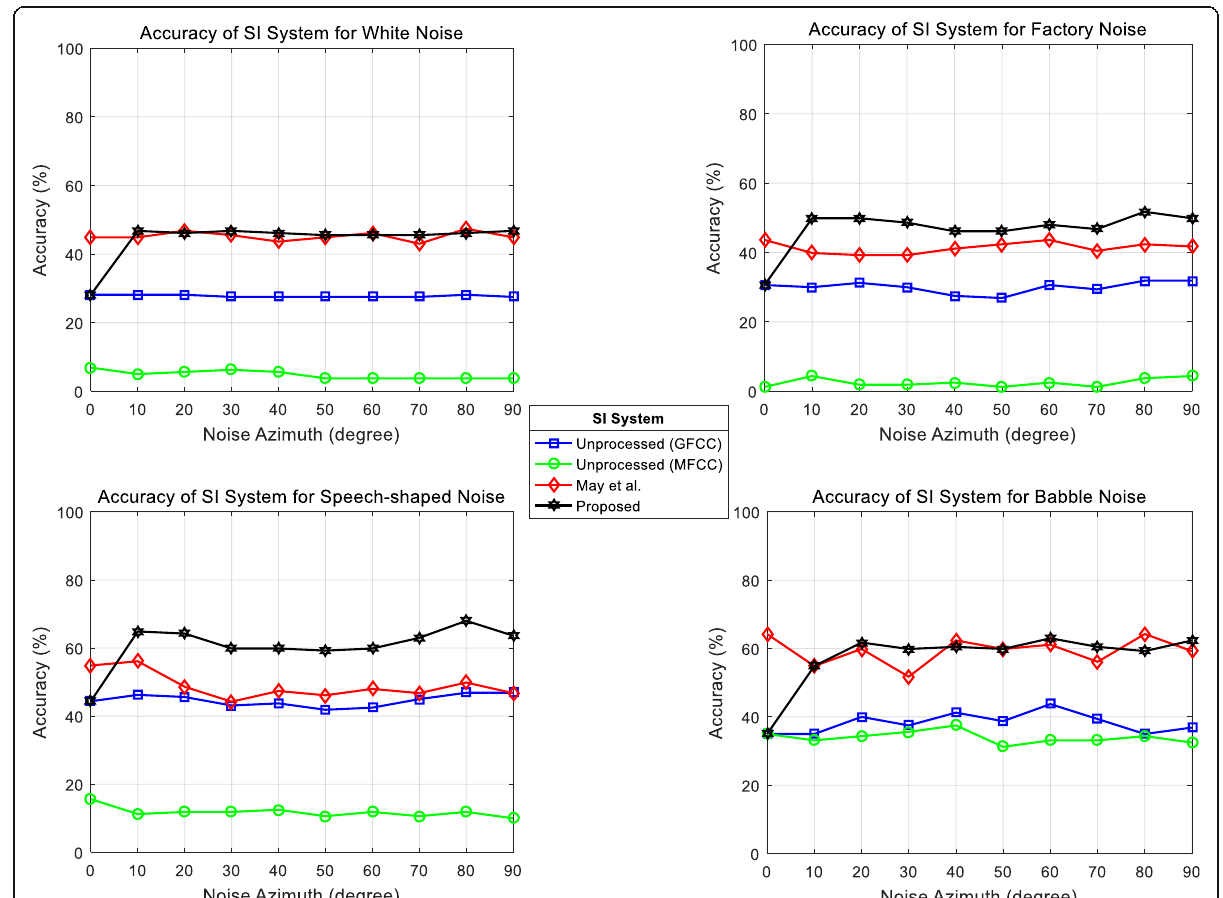
Fig. 9 The accuracy of the SI systems obtained in reverberant ( T 60 = 0.29 s) and additive noise conditions with four types of noises at SNR = 0